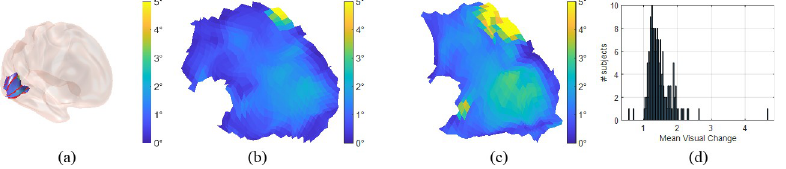
Fig 12. Visual coordinate change after smoothing. (A) The visual change is rendered on the inflated cortical surface (B) The visual change is rendered on the parametric surface for the first observer. Similarly, (C) is the visual change for the second observer. (D) is the histogram of average visual change for the HCP dataset (N = 181).